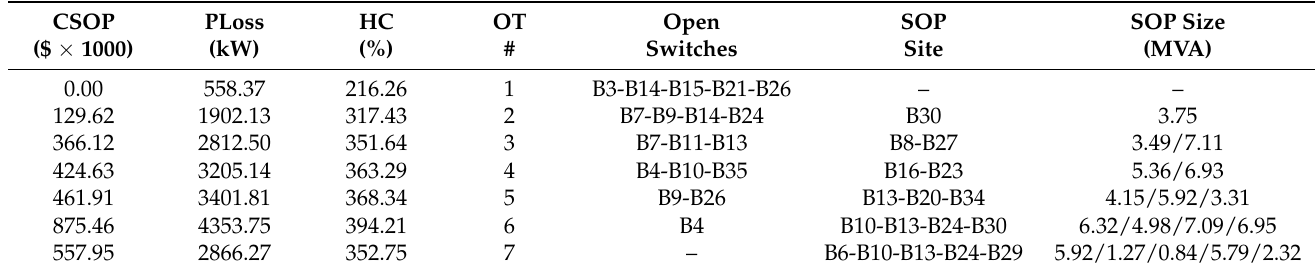
Table 8. Some solutions from the Pareto front.